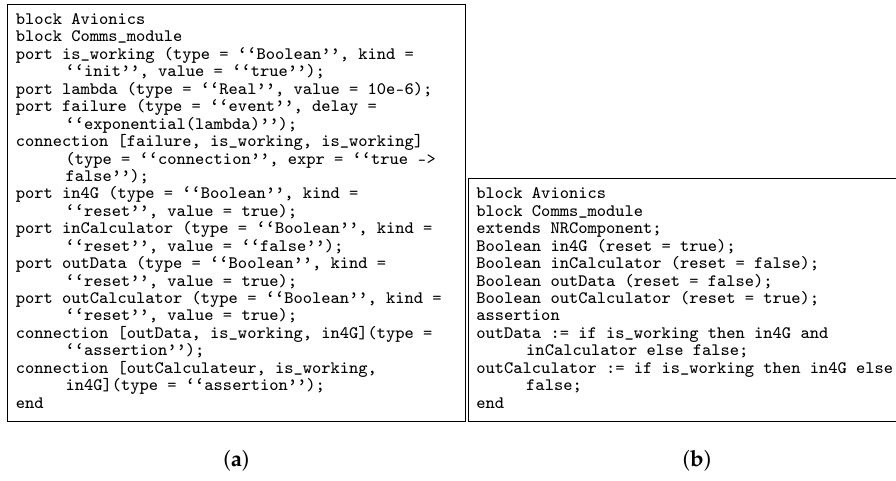
Figure 14. A part of the AltaRica 3.0 model ( b ) and its translation in the S2ML model ( a